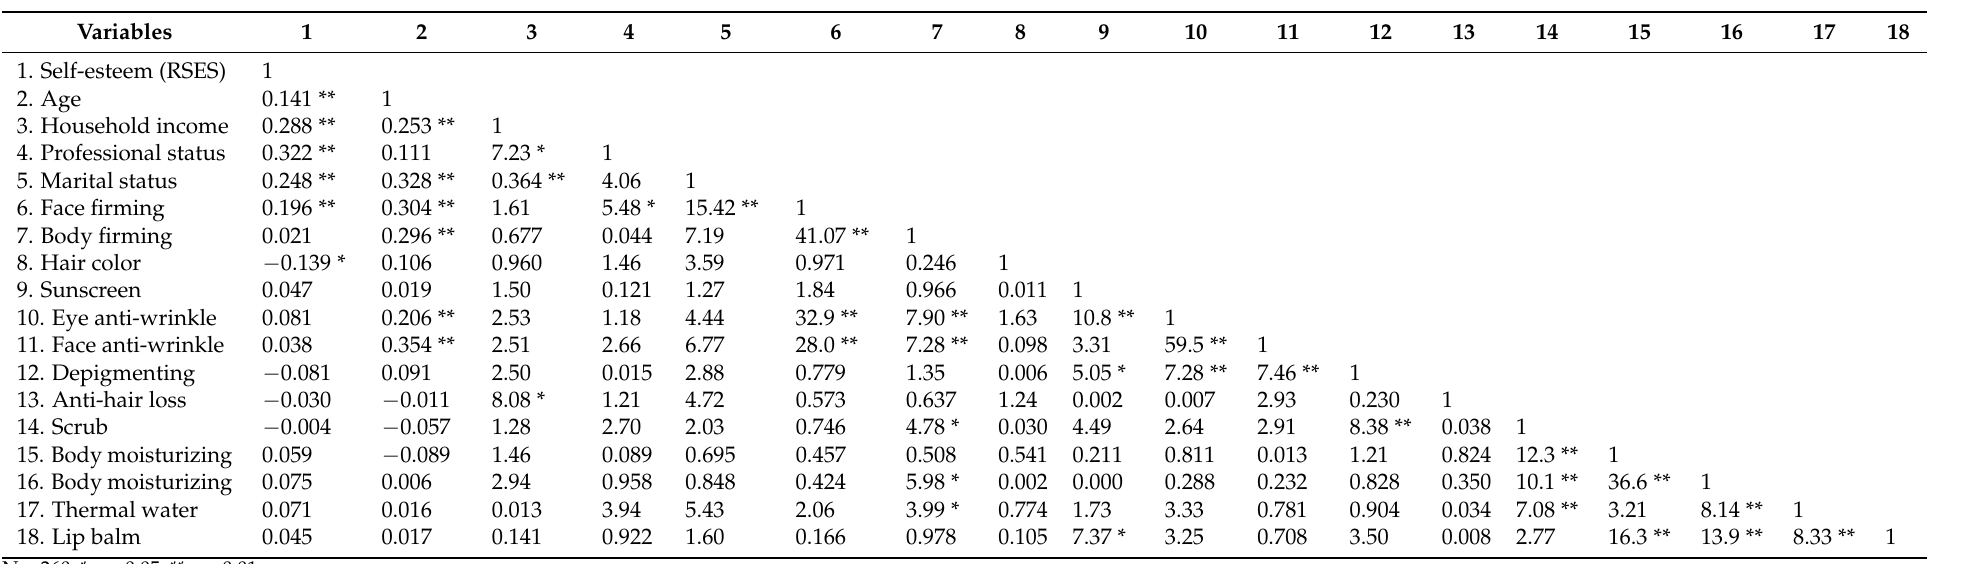
Table 3. Correlation between sociodemographic variables, anti-aging product consumption, and